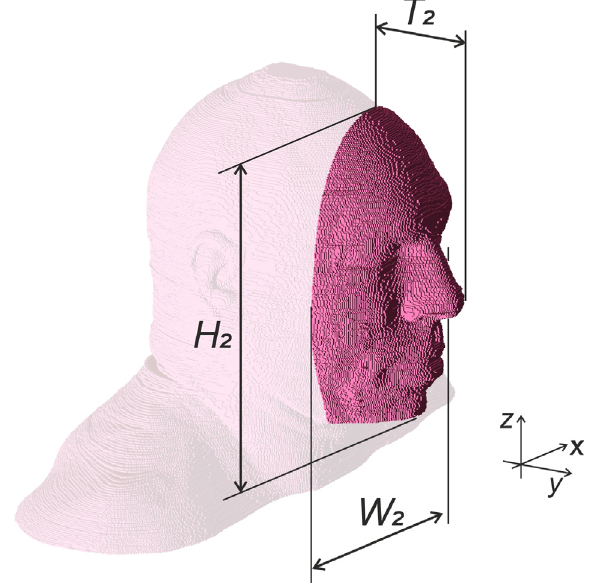
Figure 4. Heterogeneous model of the head fragment (face model). Table 2. The comparison of the reference model and the cutout model.